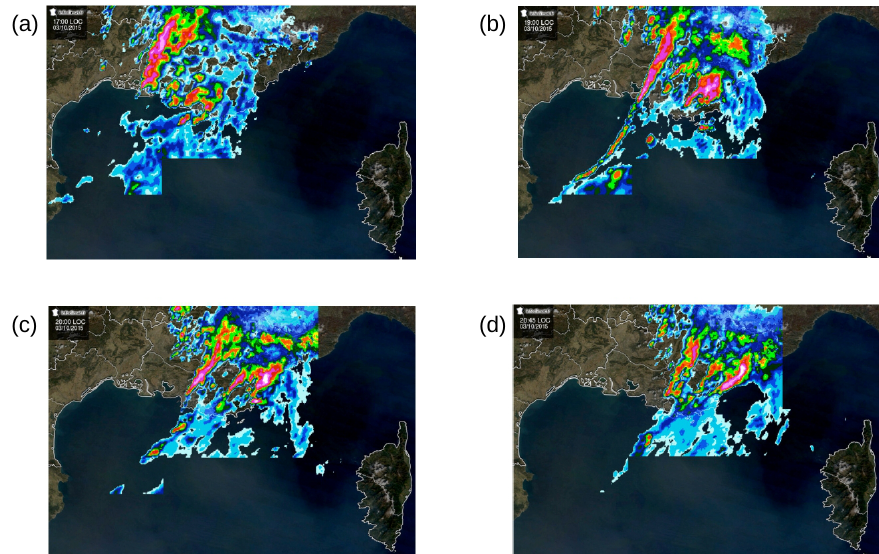
Figure 3. Radar image of precipitation that hit Provence-Alpes-Côte d’Azur region at ( a ) 17.00, ( b ) 19.00, ( c ), 20.00 and ( d ), 20.45 local time. Colour scale ranges from light blue for light rain to white for heavy rain. National Weather Service (Meteo France).